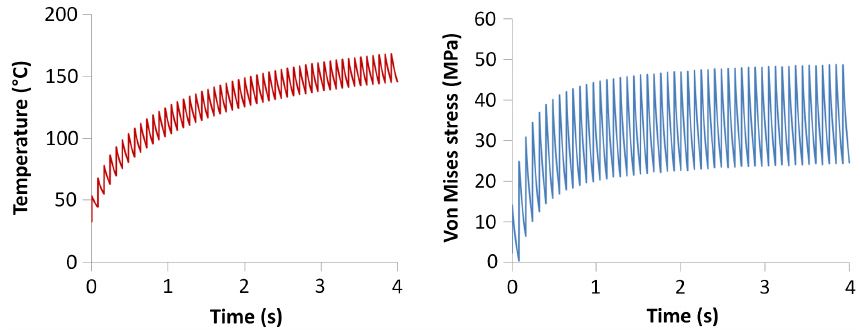
FIG. 7. Temperature (left) and von Mises stress (right) for a 0.25 mm thick beryllium window circumferentially cooled by forced convection